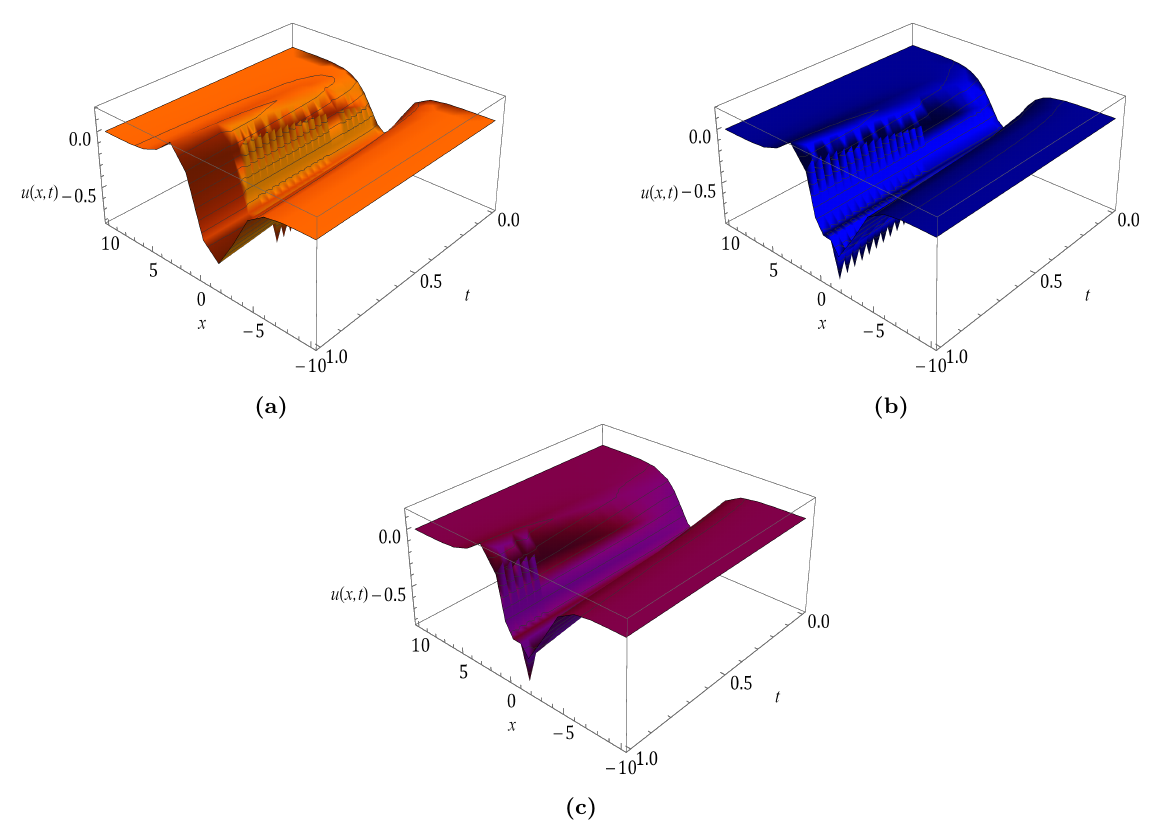
Figure 5. Surfaces of q -HATT solution for ( a ) Caputo, ( b ) CF and ( c ) AB fractional operator at n = 1 , (cid:125) = − 1 , β = 8 , α = 1 and F r = −